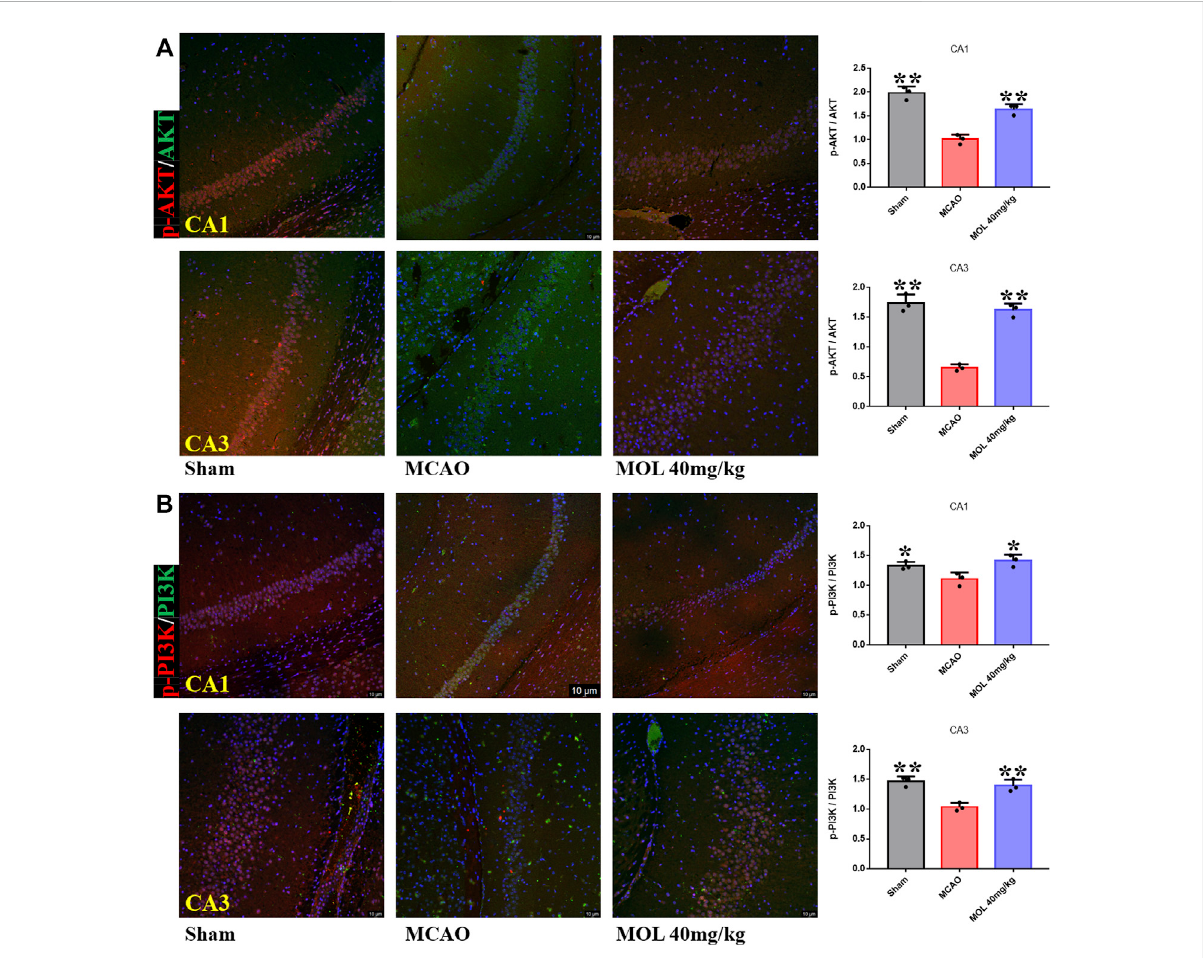
FIGURE 7 MOL treatment can activate PI3K/AKT pathway in hippocampus of MCAO rats. (A) MOL (72.4 μ M/kg) treatment up-regulated p-Akt/AKT in hippocampalCA1andCA3regionsofMCAOrats; (B) MOL(72.4 μ